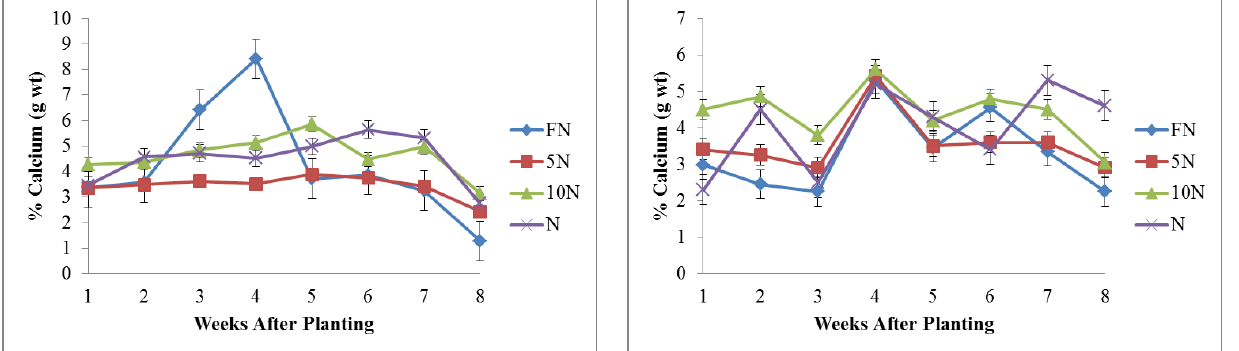
Fig. 6a. The effect of nitrogen nutritional stress on the percent- age calcium content of Vigna unguiculata measured at different periods